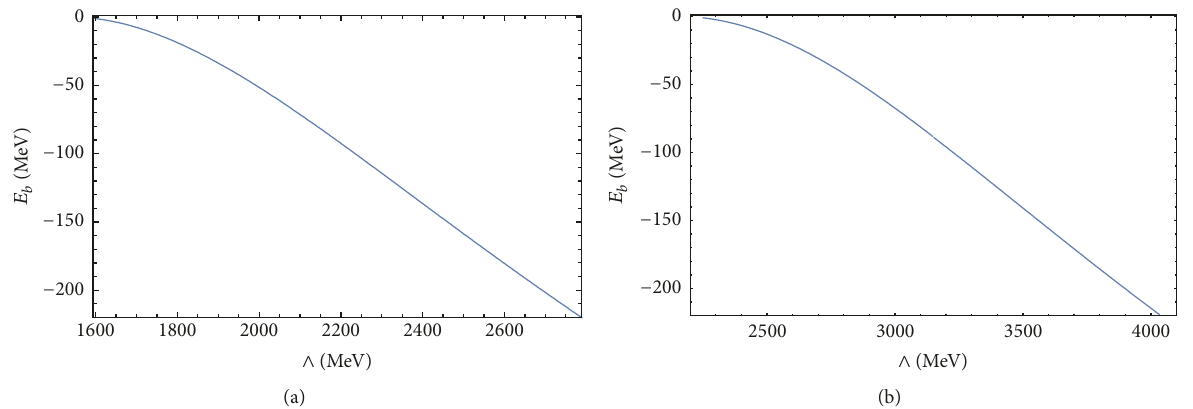
Figure 1: Relation of the cutoff Λ and the binding energy 𝐸 푏 with (a) the monopole form factor and (b) the dipole form factor for 𝐼 = 0 .